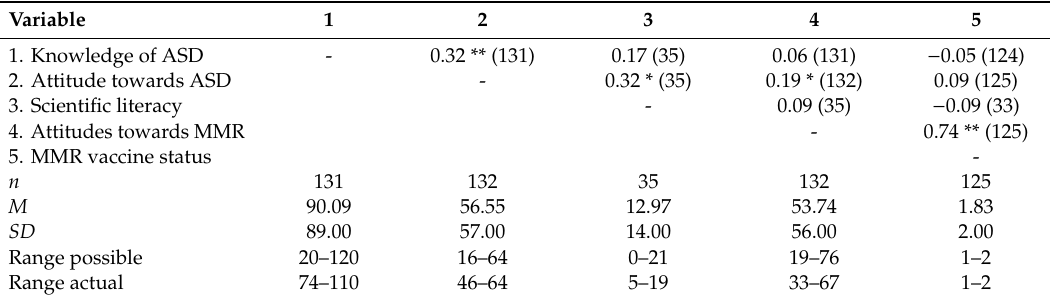
Table 1. Pearson’s correlation (n) matrix for key